Question: What type of chart is this?
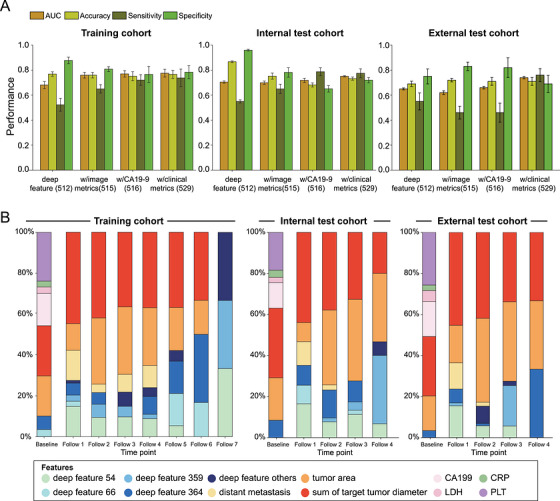
Answer: bar